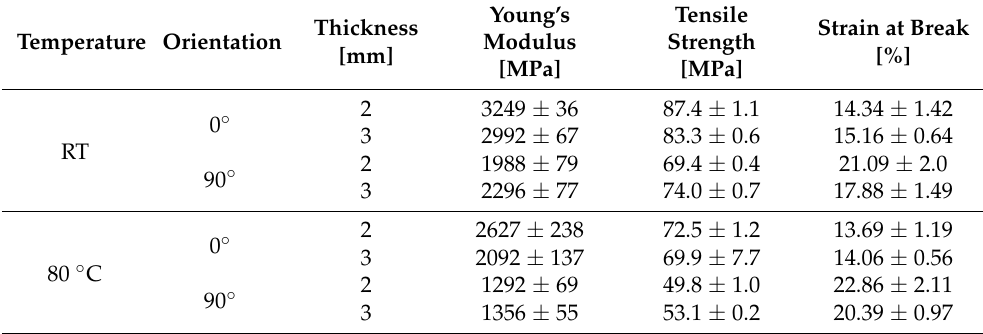
Figure 4. Stress-strain curves for the 30% fiber weight content of 2 mm thick specimens ( left ) and 3 mm thick specimens ( right ) at room temperature ( bottom ) and 80 °C ( top ). Curves display the average of five specimens, and the envelope marks the standard deviation. Table 1. Engineering values (exemplary for the 15% fiber weight content) from the tensile tests; average of five specimens tested for each parameter set with the standard deviation.